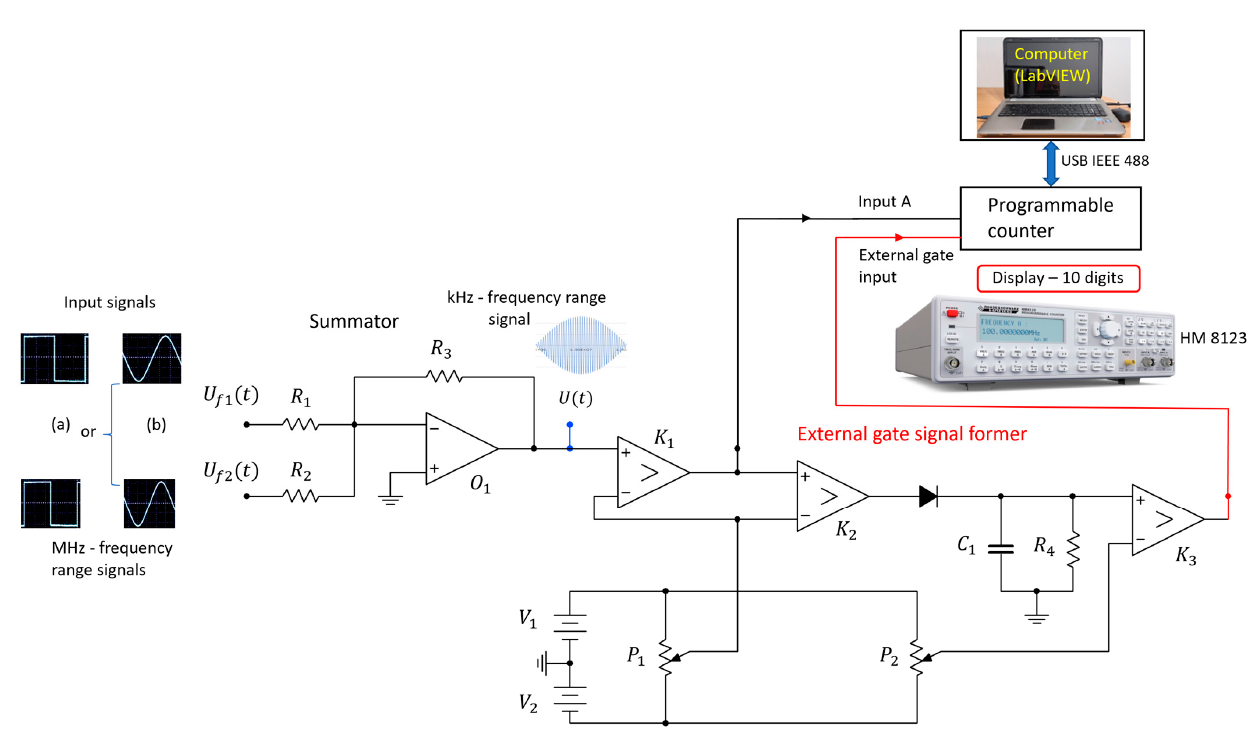
Figure 2. Experimental setup to count the number of transitions through zero within one beat period. Input signals are of ( a ) rectangular or ( b ) sinusoidal form.